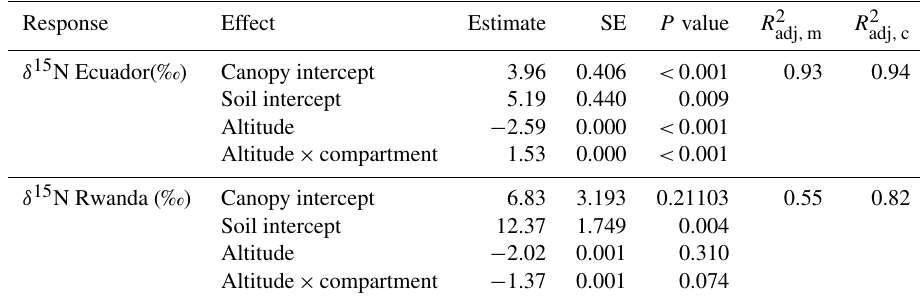
Table 3. Fixed effects estimates (altitude in kma.s.l.) for δ 15 N in both canopy and topsoil (compartment) on both transects, along with the estimated marginal (m) and conditional (c) R 2 (sensu Nakagawa and Schielzeth, adj